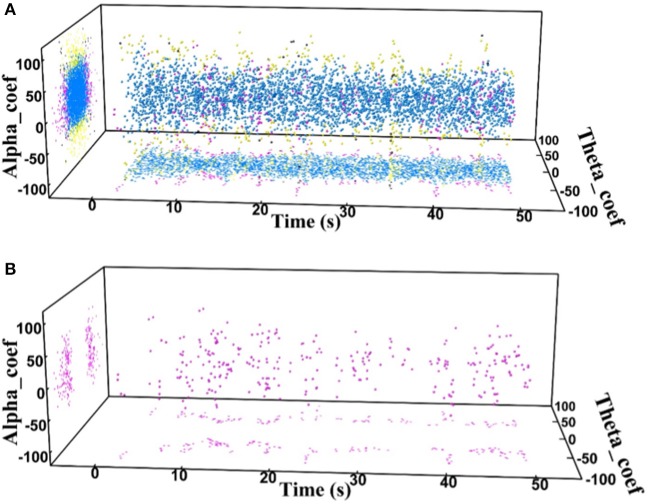
(A) The distributions of the four states in one neuropathic pain patient's PVAG over time; α0θ0 (blue dots), α0θ1 (pink dots), α1θ0 (yellow dots), and α1θ1 (black dots). (B) Distribution of the α0θ1 state over time.